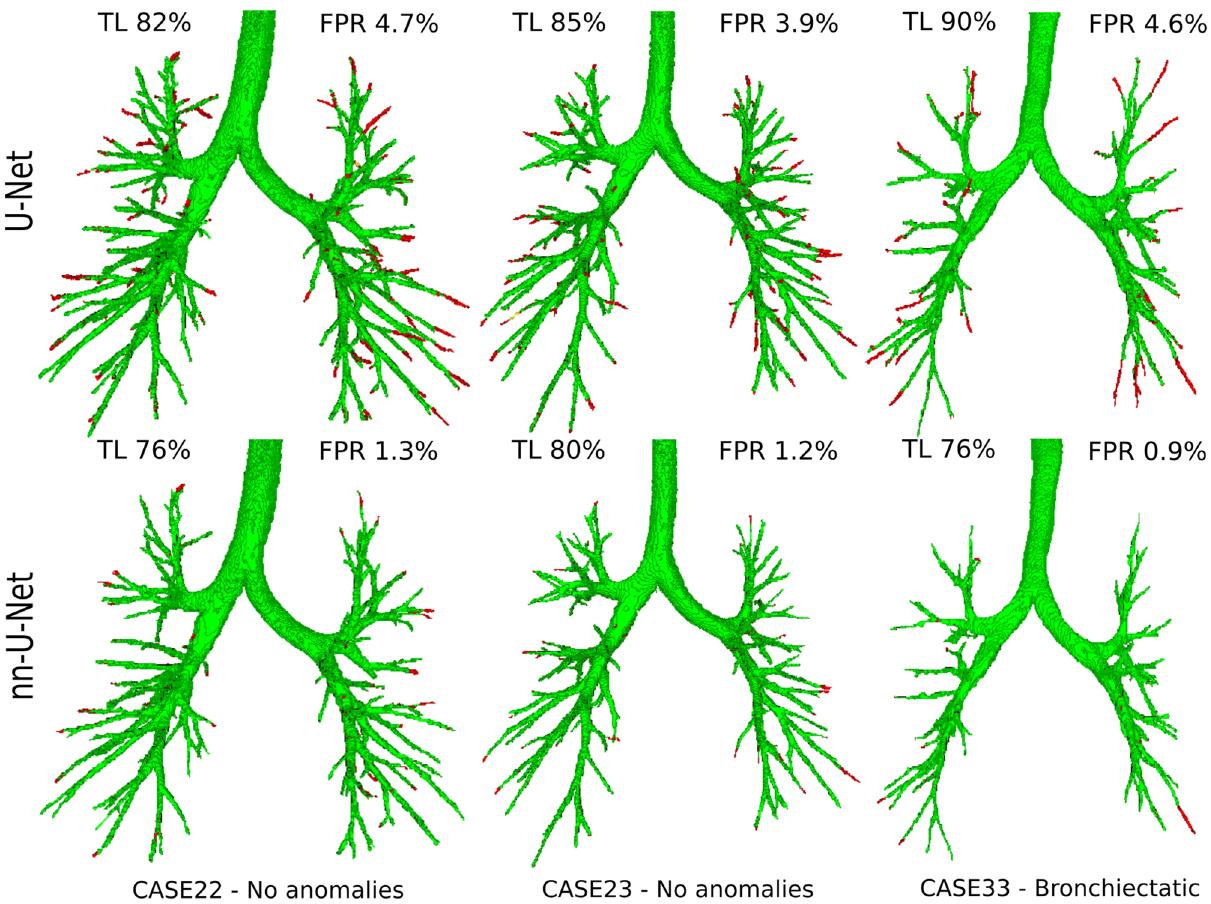
Figure 8. Visualization of predicted airway trees on the EXACT’09 data obtained by our U-Net-based method and the nnU-Net method 46 . True positives are displayed in green and false positives in red, indicated according to the EXACT’09 evaluation. The cases displayed correspond to 3 out of the 5 U-Net results with the highest false positive rate reported in the EXACT’09 evaluation, where we found through visual inspection that many of the reported false positives are real airways on the CT scan, which were presumably missing in the EXACT’09